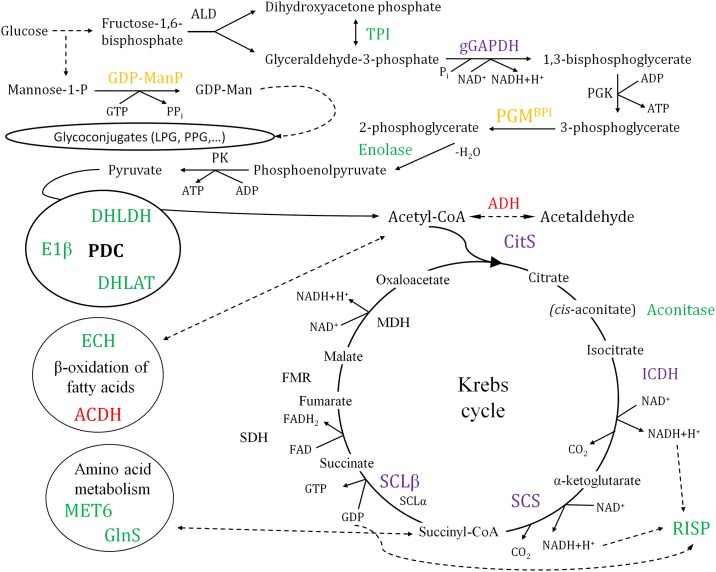
Differential abundance of proteins involved in L. amazonensis metabolism.Constitutively expressed and differentially regulated proteins that participate in glycolysis, the Krebs cycle, amino acid metabolism and β-oxidation of fatty acids are depicted. Colour legend for up-regulation: green, day 2 (lag/early log); blue, day 3 (log); orange, day 5 (late log); red, day 7 (stat). The constitutively expressed proteins experimentally detected throughout the promastigote growth curve are highlighted in violet. Abbreviations not detailed in the text: ALD, fructose-1,6-bisphosphate aldolase; ECH, enoyl-CoA hydratase/isomerase; FMR, fumarase; MET6, methyltetrahydropteroyltriglutamate-homocysteine methyltransferase; MDH, malate dehydrogenase; PGK, phosphoglycerate kinase; PK, pyruvate kinase; SDH, succinate dehydrogenase.